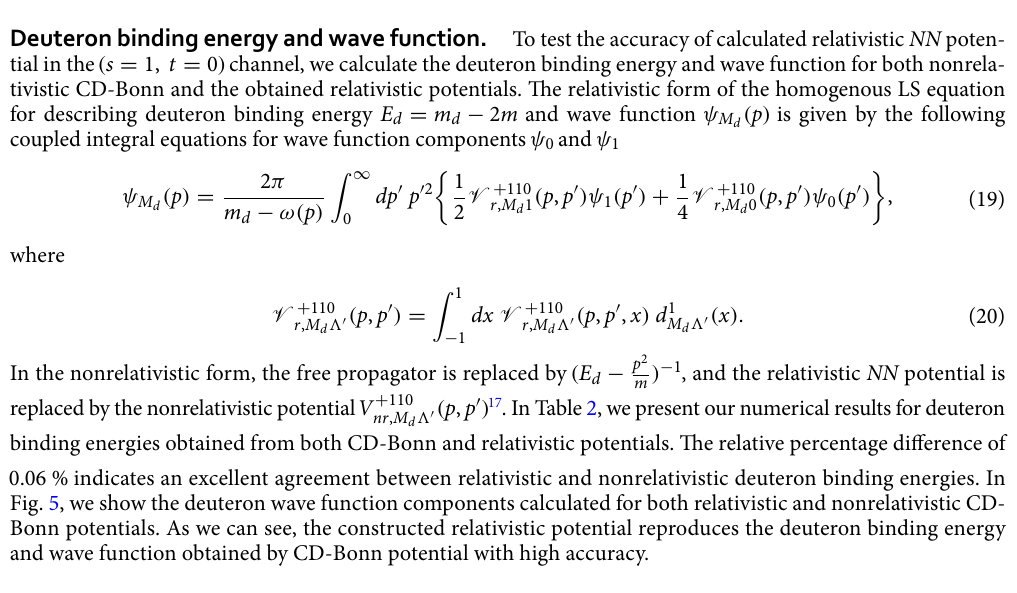
Figure 2. The same as Fig. 1, but for ( s